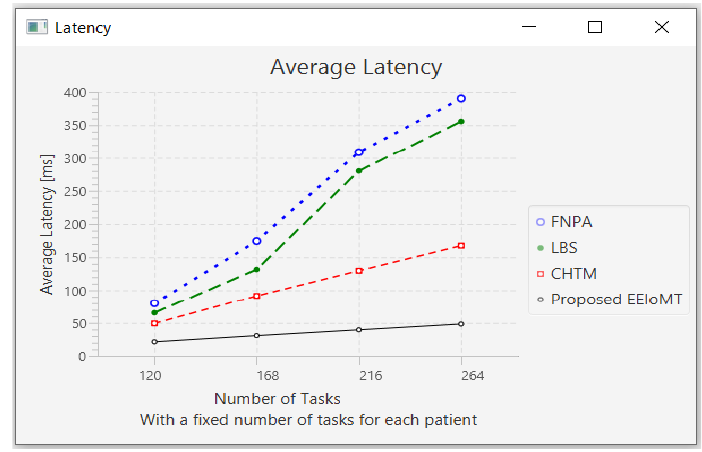
Figure 20. Average latency comparison when changing the number of tasks.